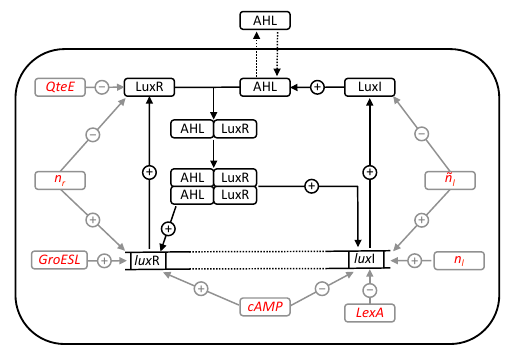
TABLE I: Model variables of the basic Quorum sensing